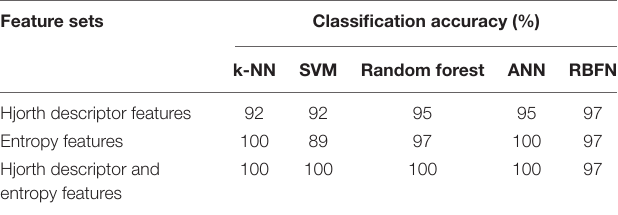
TABLE 2 | Classification performance of each feature set. Feature sets Classification accuracy